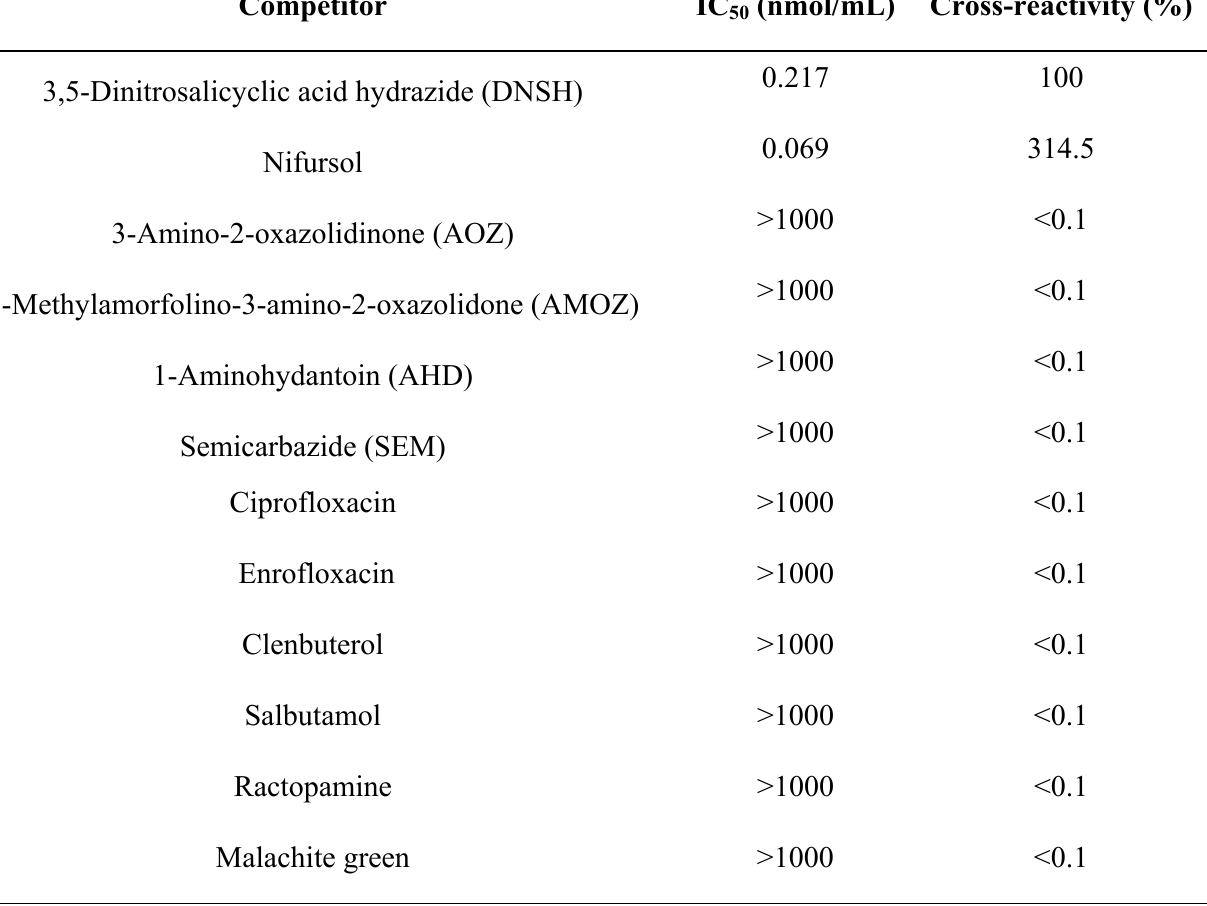
Table 2. Cross-reactivity of the antibody with various